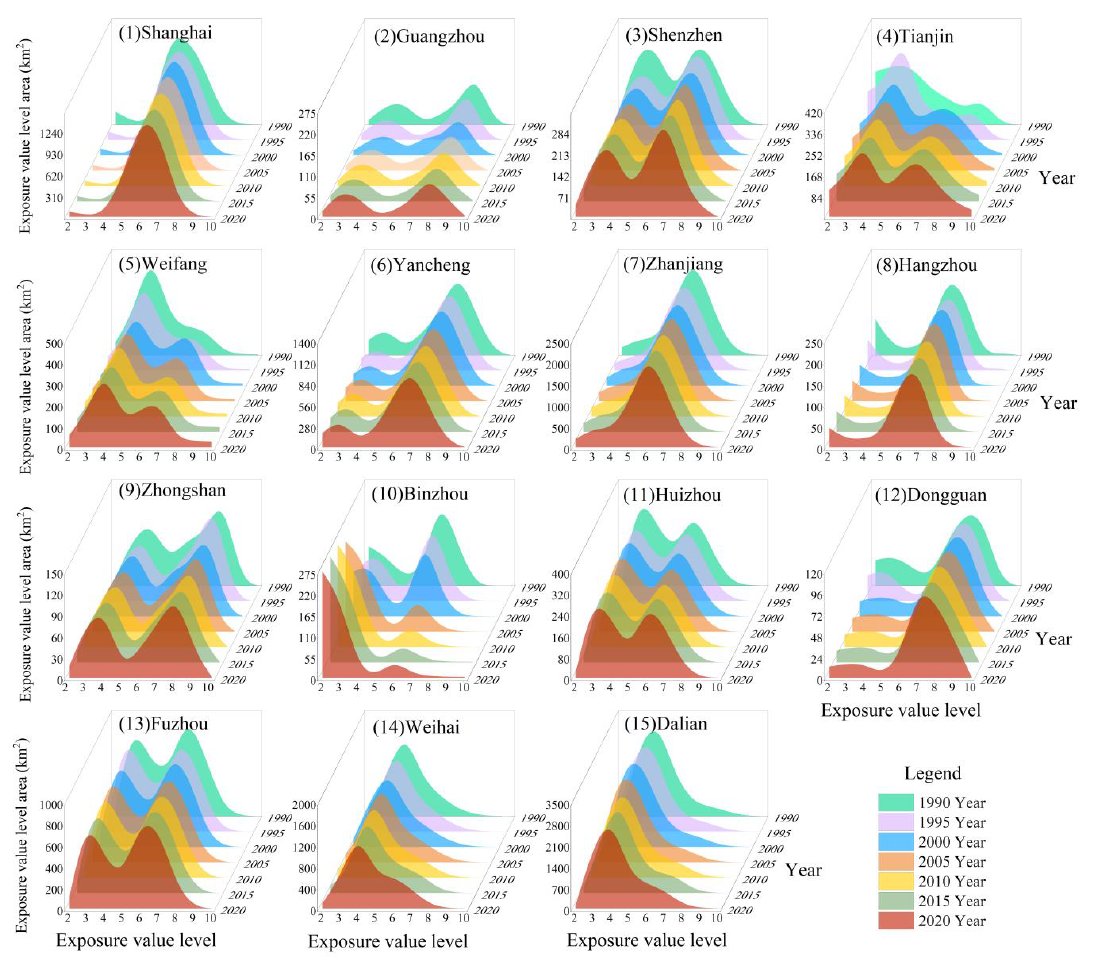
Figure 4. Frequency distribution map of exposure grade area in 15 coastal cities of China from 1990 to 2020.